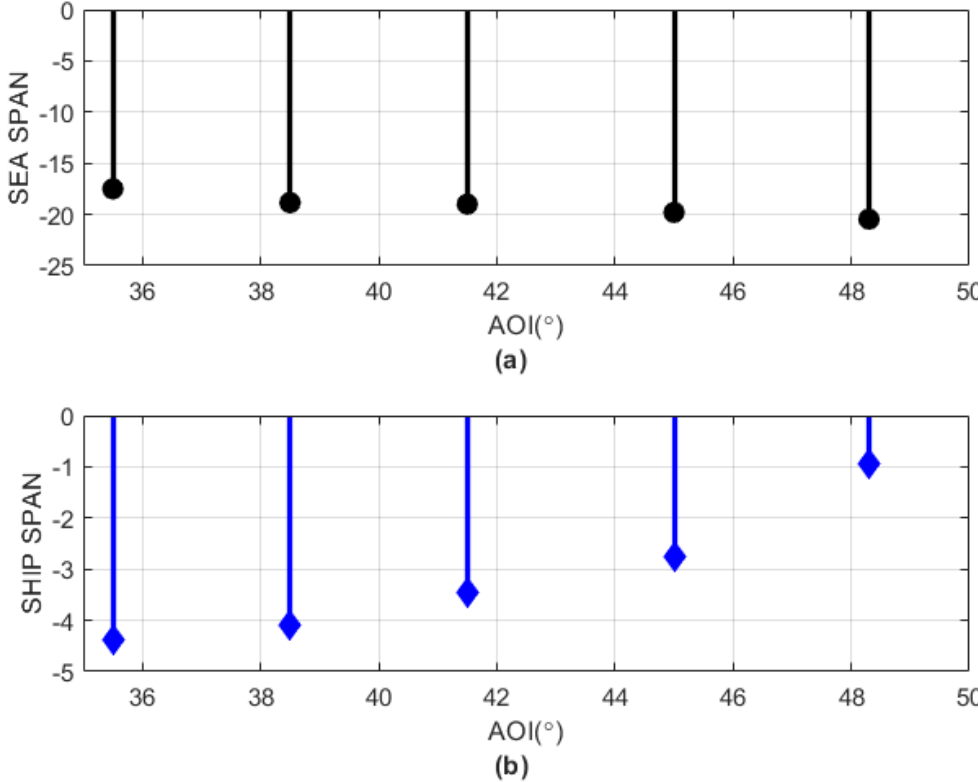
Figure 8. SPAN evaluated at the five AOIs for: ( a ) sea and ( b ) ship ROIs. The dB scale is